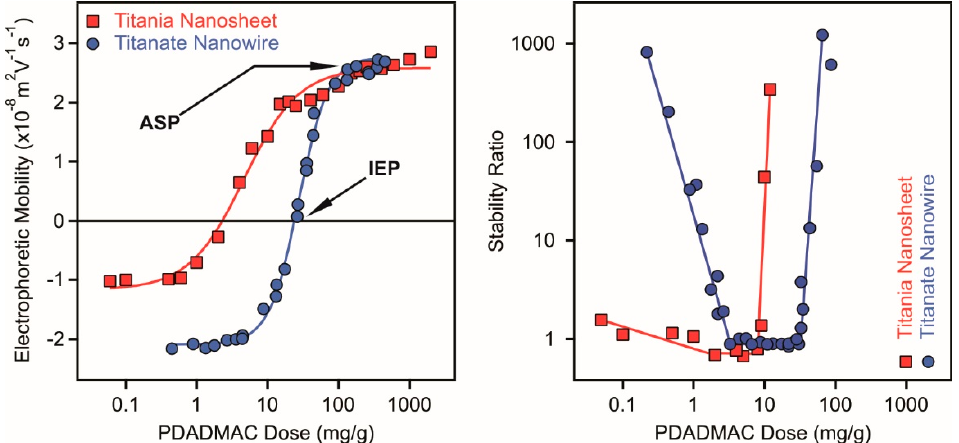
Figure 6. Electrophoretic mobilities ( left ) and stability ratios ( right ) of titania nanosheets (squares) and titanate nanowires (circles) at different doses of PDADMAC polyelectrolyte at 4.5 mM and 1 mM ionic strengths, respectively. The mg/g unit refers to mg PDADMAC per one gram of particle. The data were taken from References [31,63].